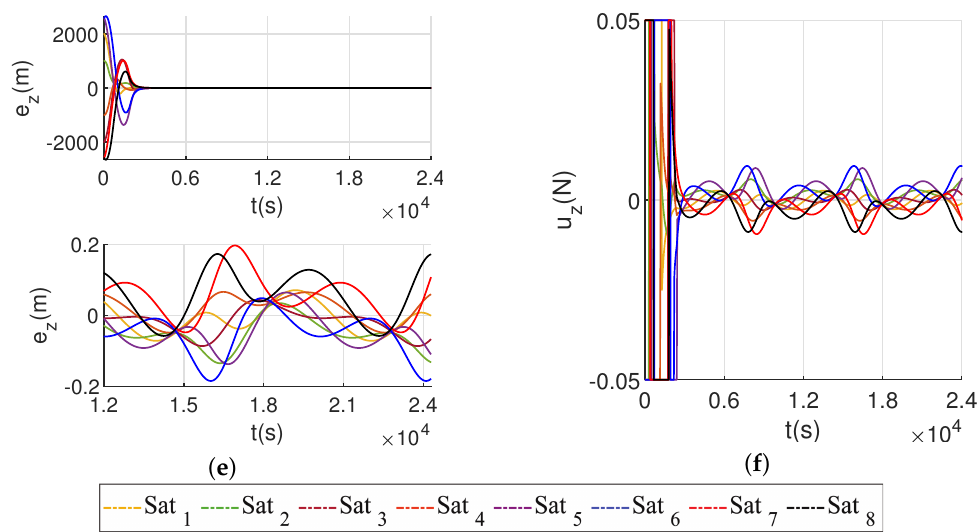
Figure 9. PDC law. Error and control time histories: ( a ) errors along axis x; ( b ) controls along axis x; ( c ) errors along axis y; ( d ) controls along axis y; ( e ) errors along axis z; ( f ) control along axis z.